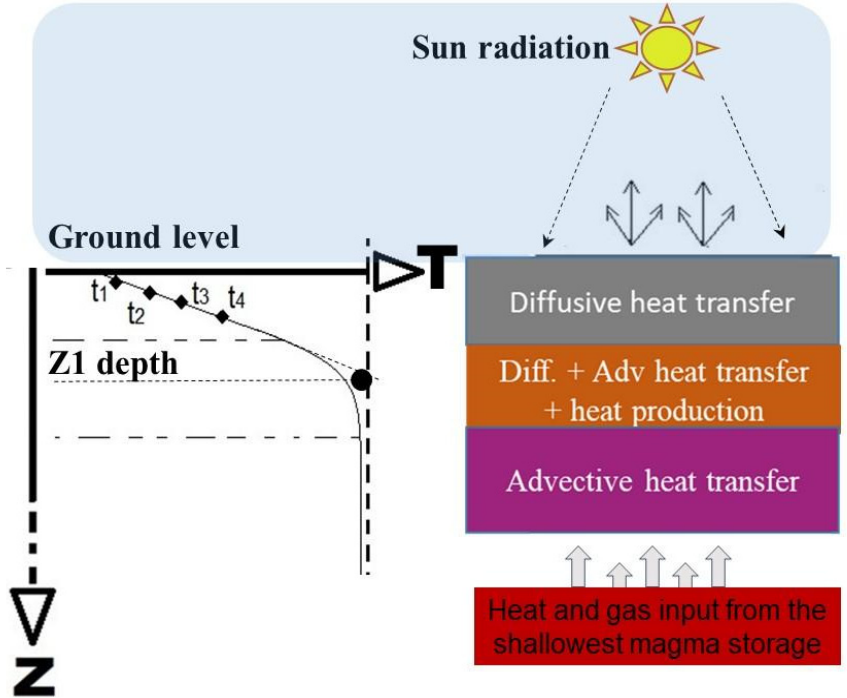
Figure 2. Model of the temperature gradient at BTL station (on the left): δ T/ δ Z is linear between Z1 and the surface when the conductive transfer dominates along the monitored profile. Model of the monitored soil profile with indication of the prevailing main heat transfer processes (on the right). Modified from Diliberto [17].